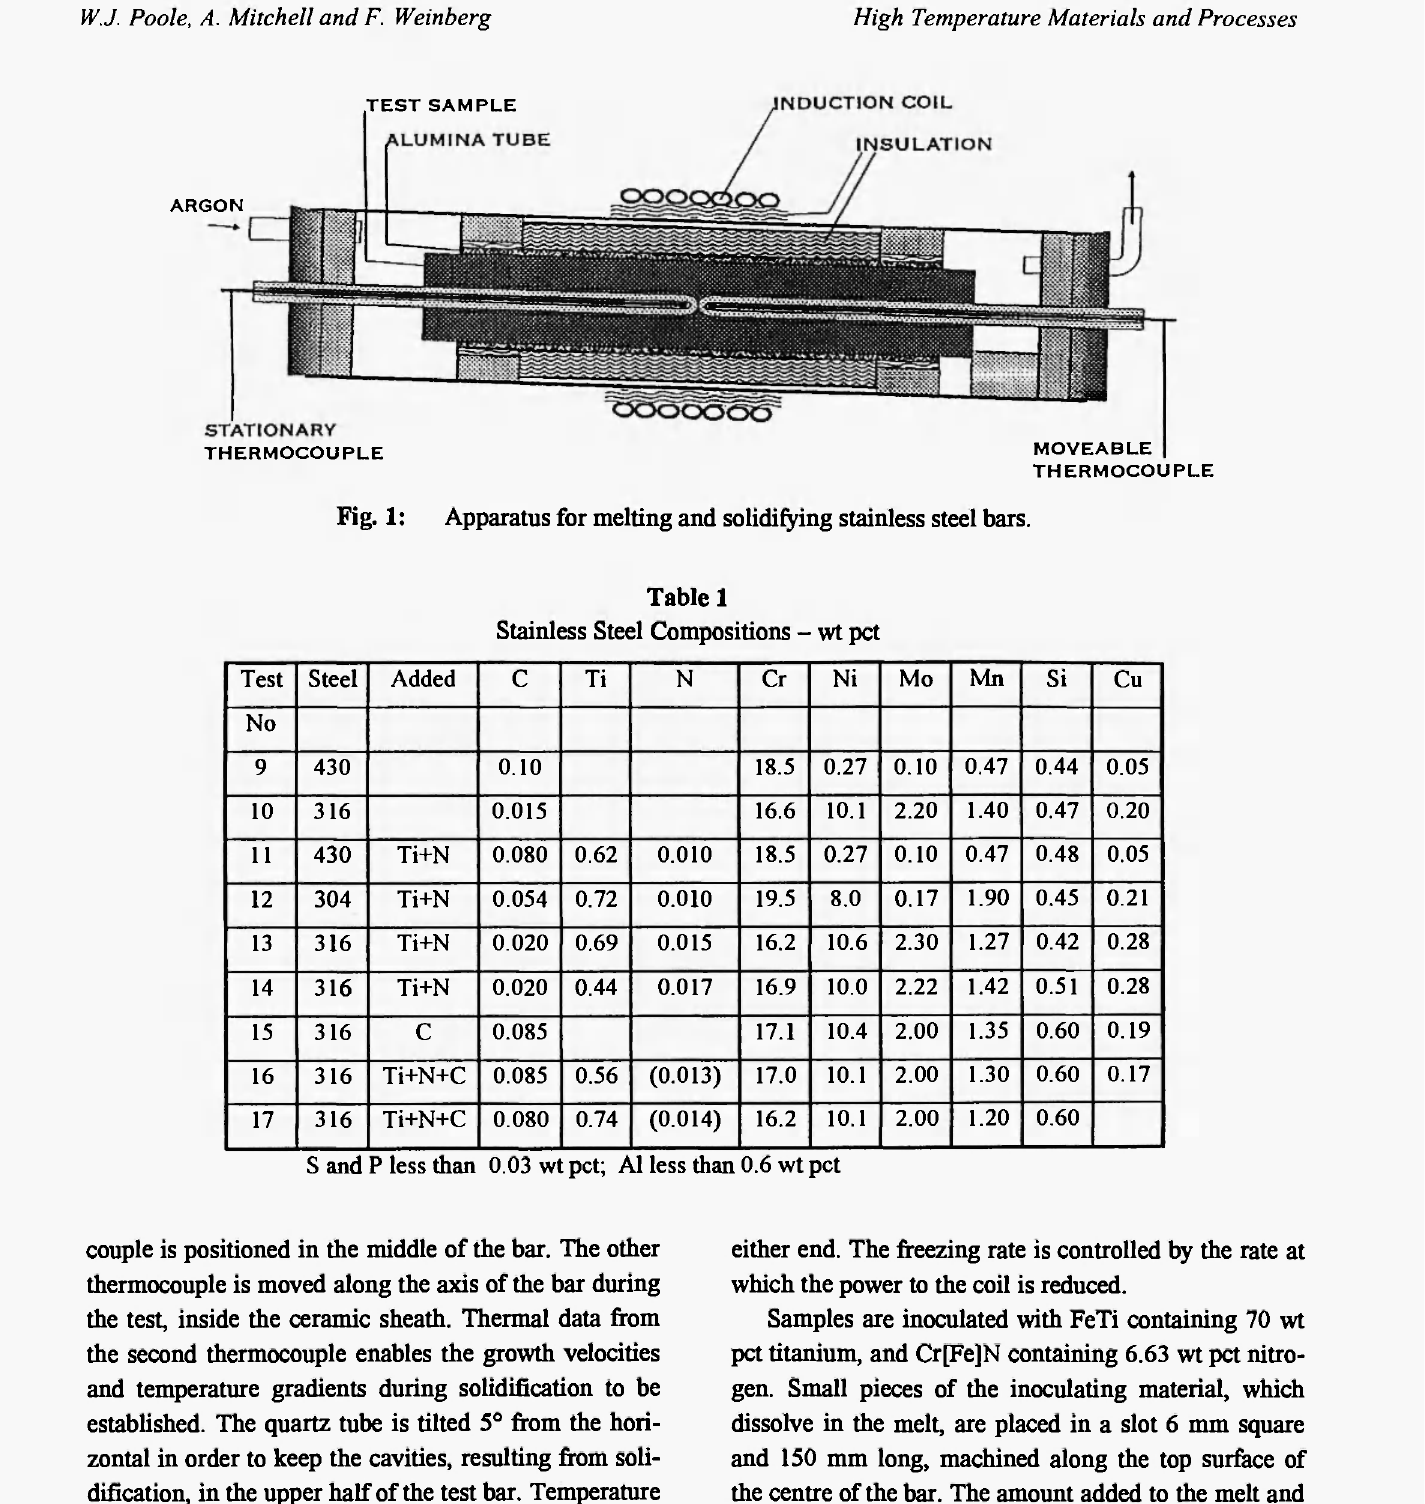
Apparatus for melting and solidifying stainless steel